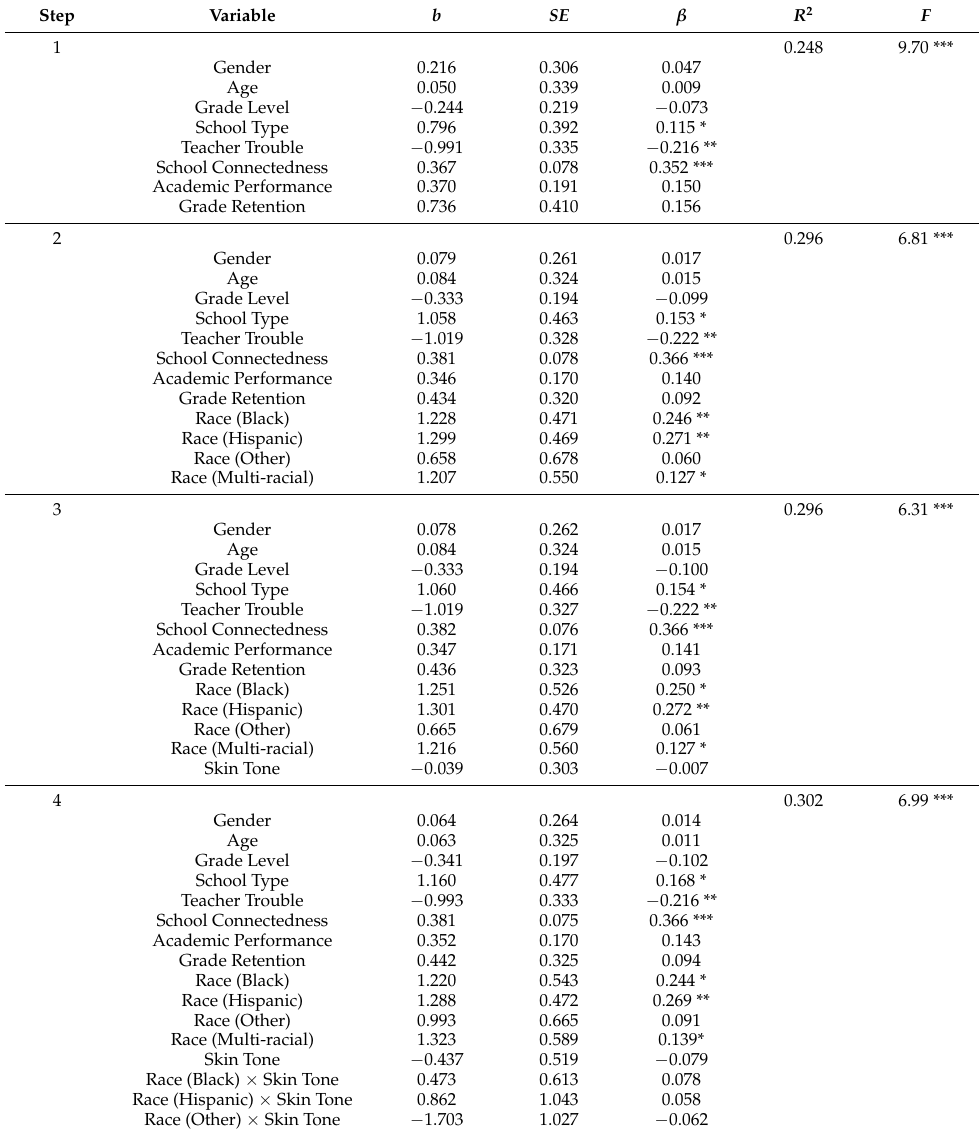
Table 2. Hierarchical regression analysis for teacher–student relationships ( n =